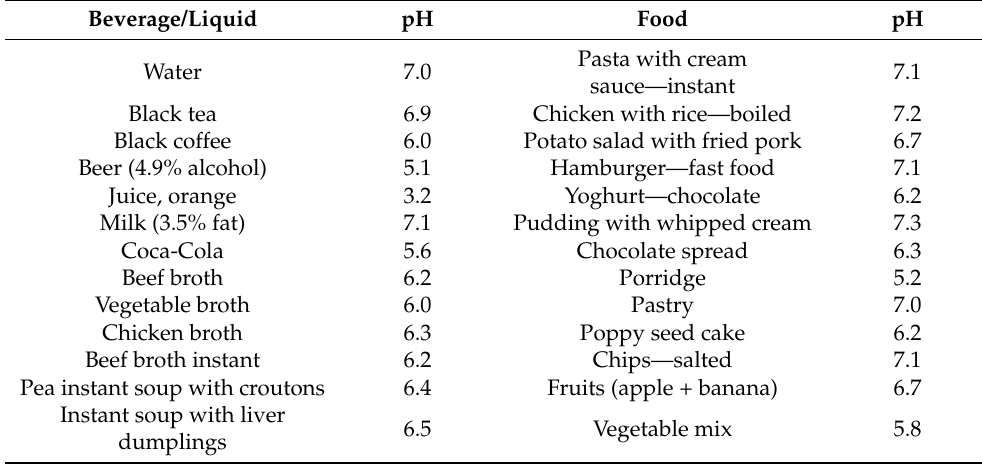
Table 3. pH values in real beverages and